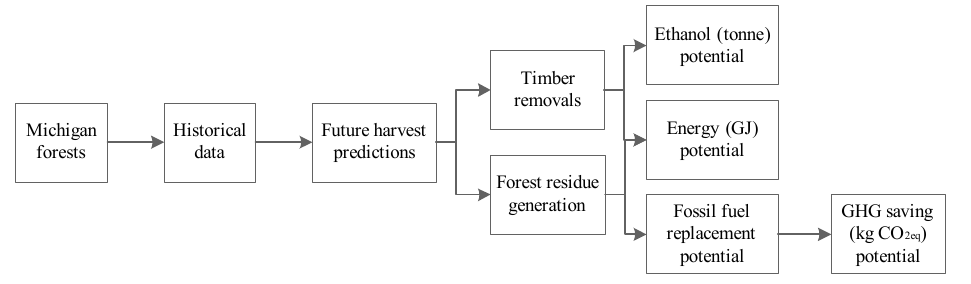
Figure 2. A description of the study theme.